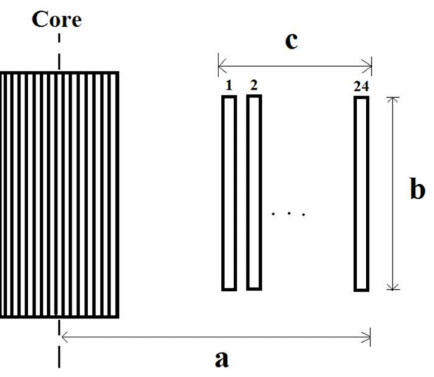
Figure 7. Sectional detail of layers 1 to 24 of LV winding considered in a lumped configuration.